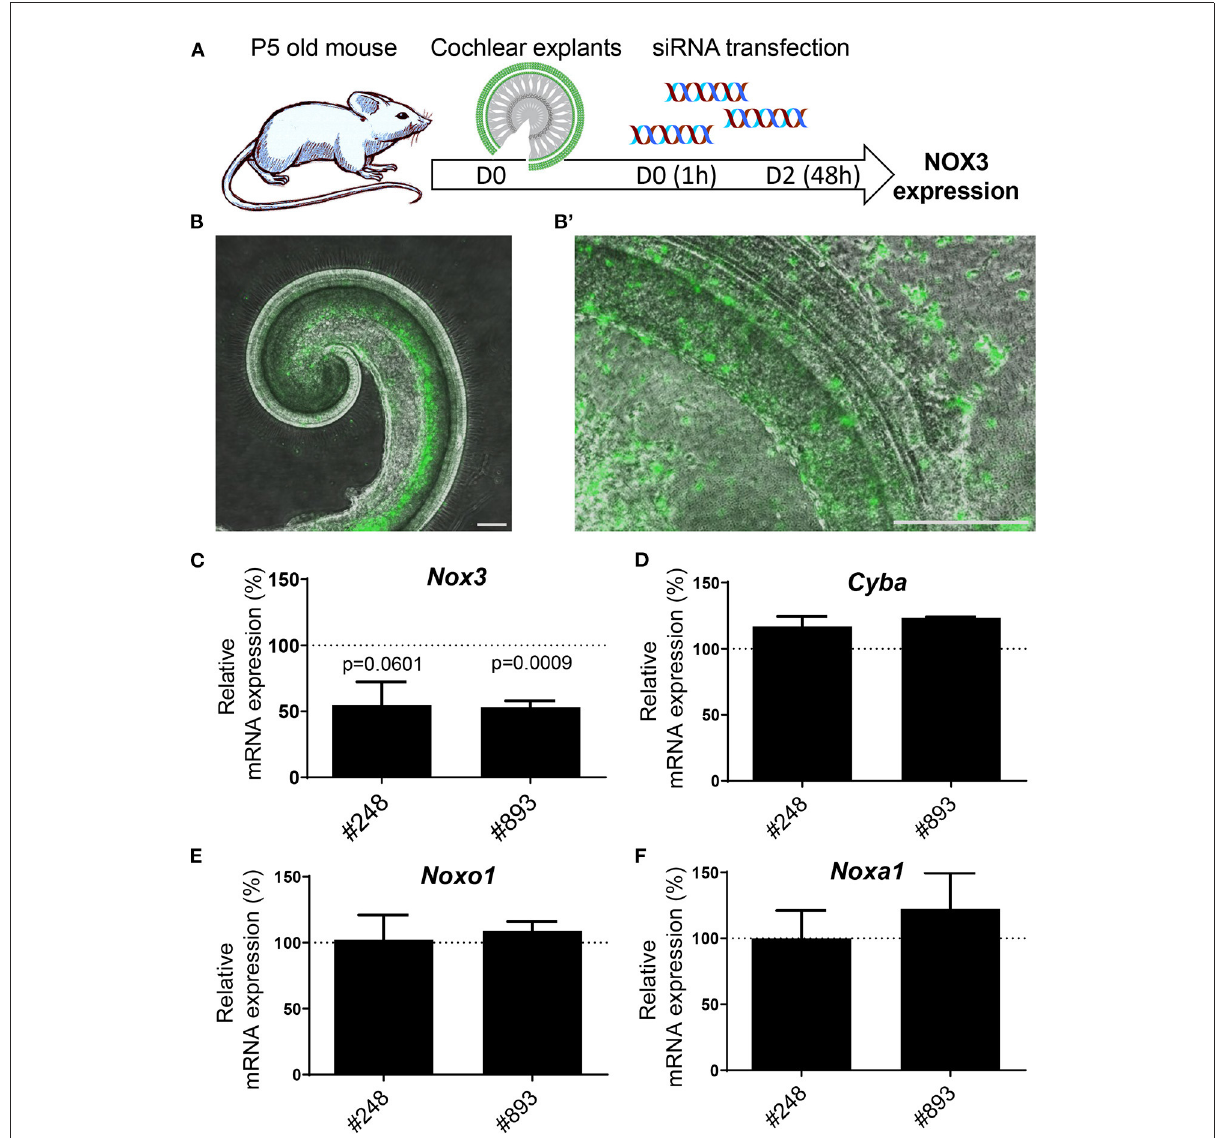
FIGURE4 Efficiency of siRNA #248 and #893 on mouse cochlear explants. (A) Mouse cochlear explants were isolated from 5 days old C57Bl6/J mice and transfected with either fluorescent siRNA (siGLO) or Nox3 siRNAs #248 and #893 . (B) Fluorescence microscopy picture of cochlear explants transfected with 80nM siGLO (left panel). High magnification (right panel) revealed localization and cellular types of transfected cells. Data are representative from three independent experiments. Scale bars 200 µ m. C-F) mRNA level of transcripts encoding for subunits of the NOX3 complex in transfected explants. The relative mRNA level is normalized to explants transfected with the control siRNA (100%). Data represent the average of three independent experiment + -